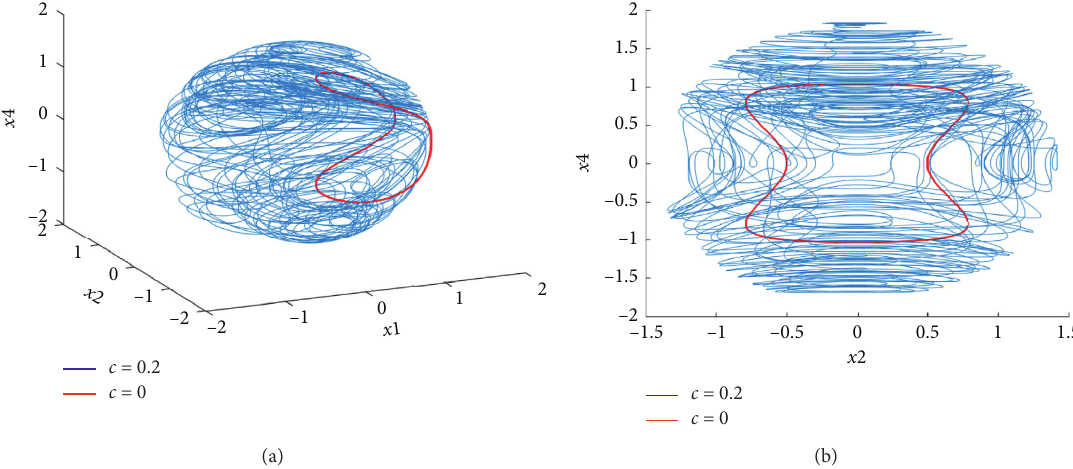
Figure 4: Phase portraits of Case 1 system on the different plane, with ( h,d, b ) � (− 1 , 2 . 5 , 2 ) and ( x space of x